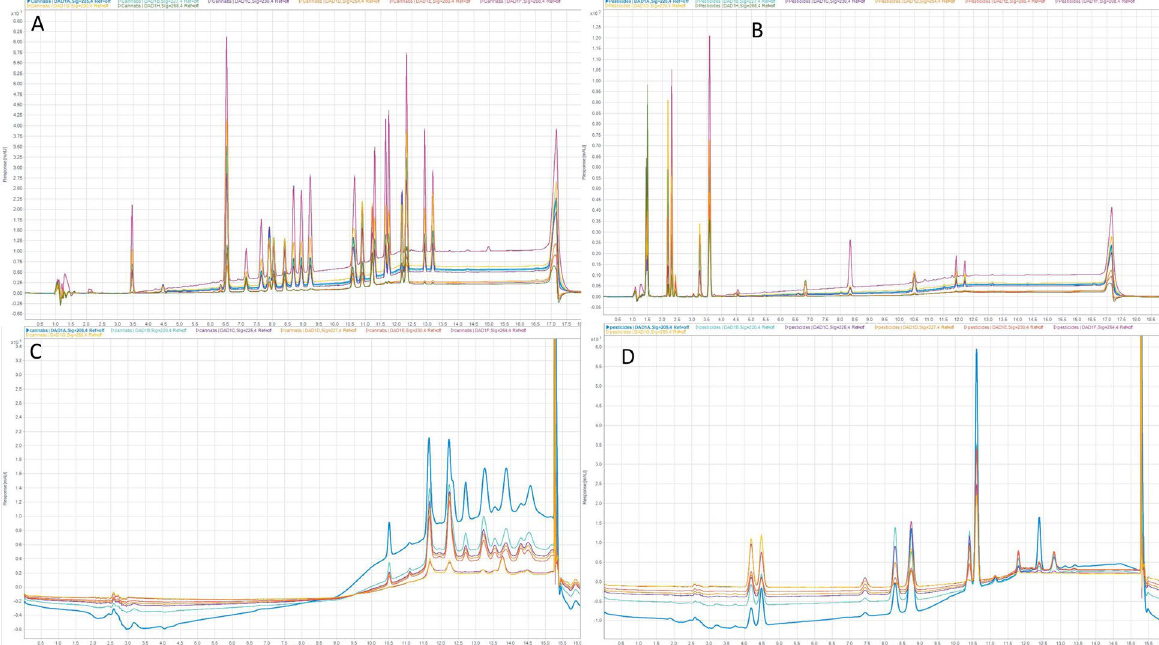
Fig. 3 Representative chromatograms of cannabinoid ( A and C ) and pesticide ( B and D ) test samples. Chromatograms A and B used the instrument method reported in "Instrument method" section. The large peak occurring at 11.1 min is likely unresolved late-eluting species such as CBTC and permethrin. Chromatograms C and D used a flow rate of 1.0 mL/min, causing peaks to elute